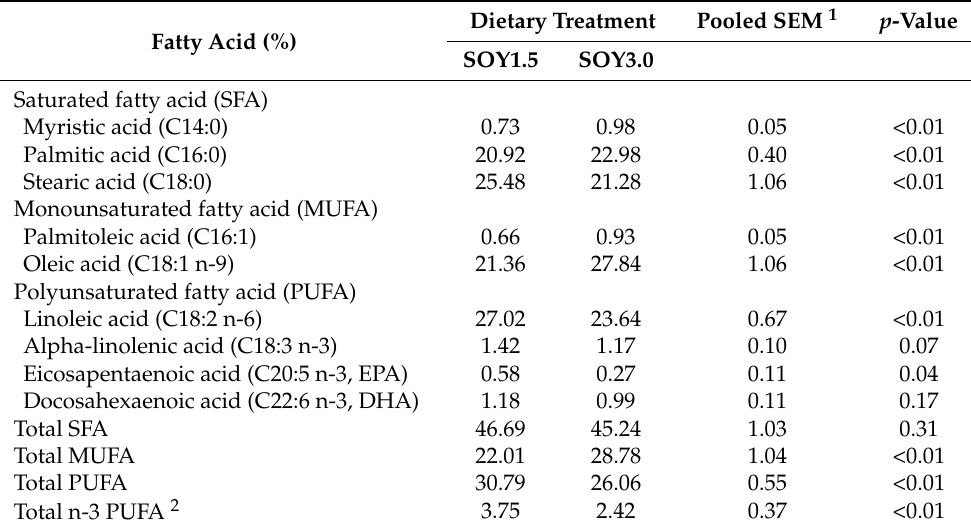
Table 2. Effects of dietary treatments on fatty acid profile of liver tissue of pigs. Dietary Treatment Pooled SEM Fatty Acid (%)